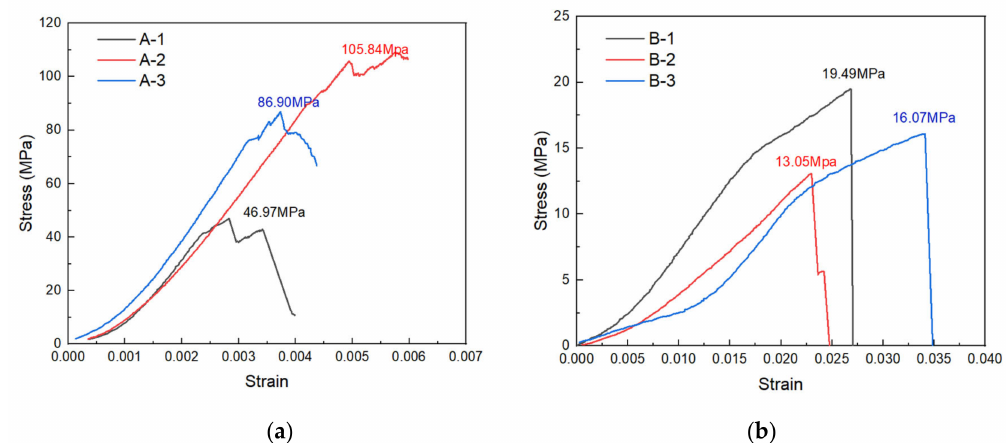
Figure 5. Stress–strain curve. ( a ) Uniaxial compression; ( b ) Brazilian